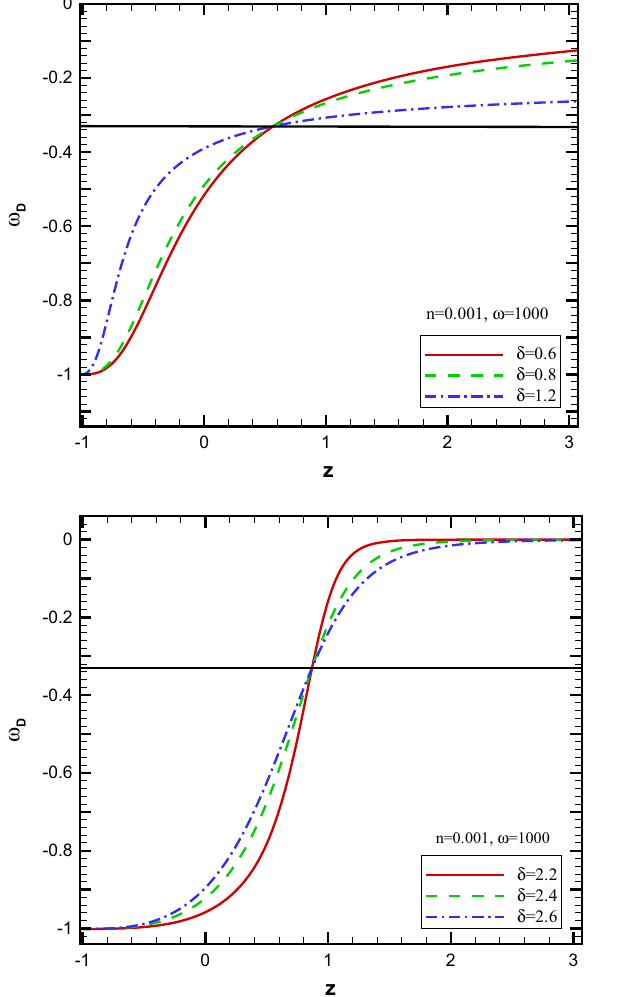
Fig. 3 The evolution of the deceleration parameter q versus redshift parameter z for the non-interacting THDE, where the different param- eter values (cid:3) k = 0 (upper panel), (cid:3) k 0 = 0 . 1 (lower panel), n = 0 . 001 and ω = 1000 are